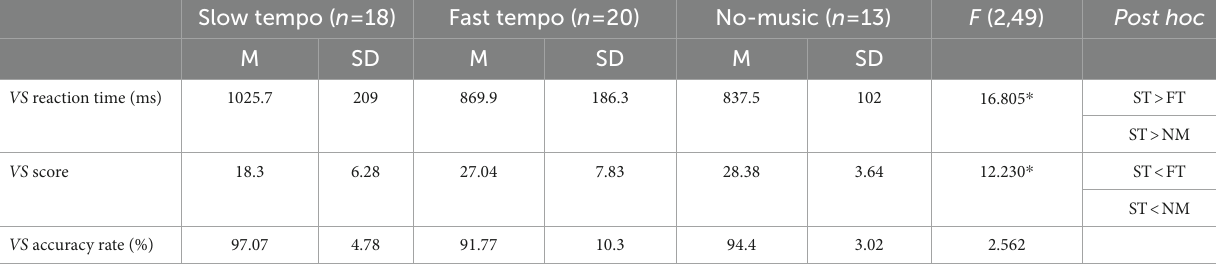
TABLE 2 Mean and standard deviation of variables in visual search ( VS )